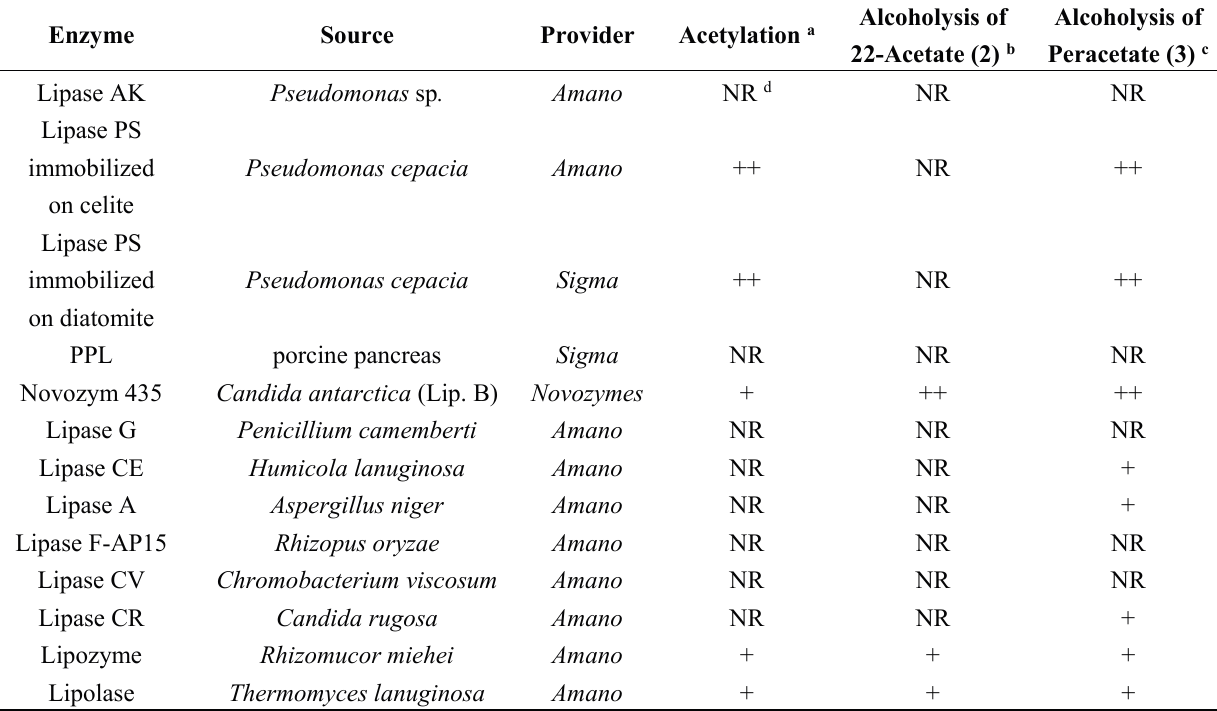
Table 1. Screening of lipases for silychristin acetylation/deacetylation. Enzyme Source Provider Acetylation a